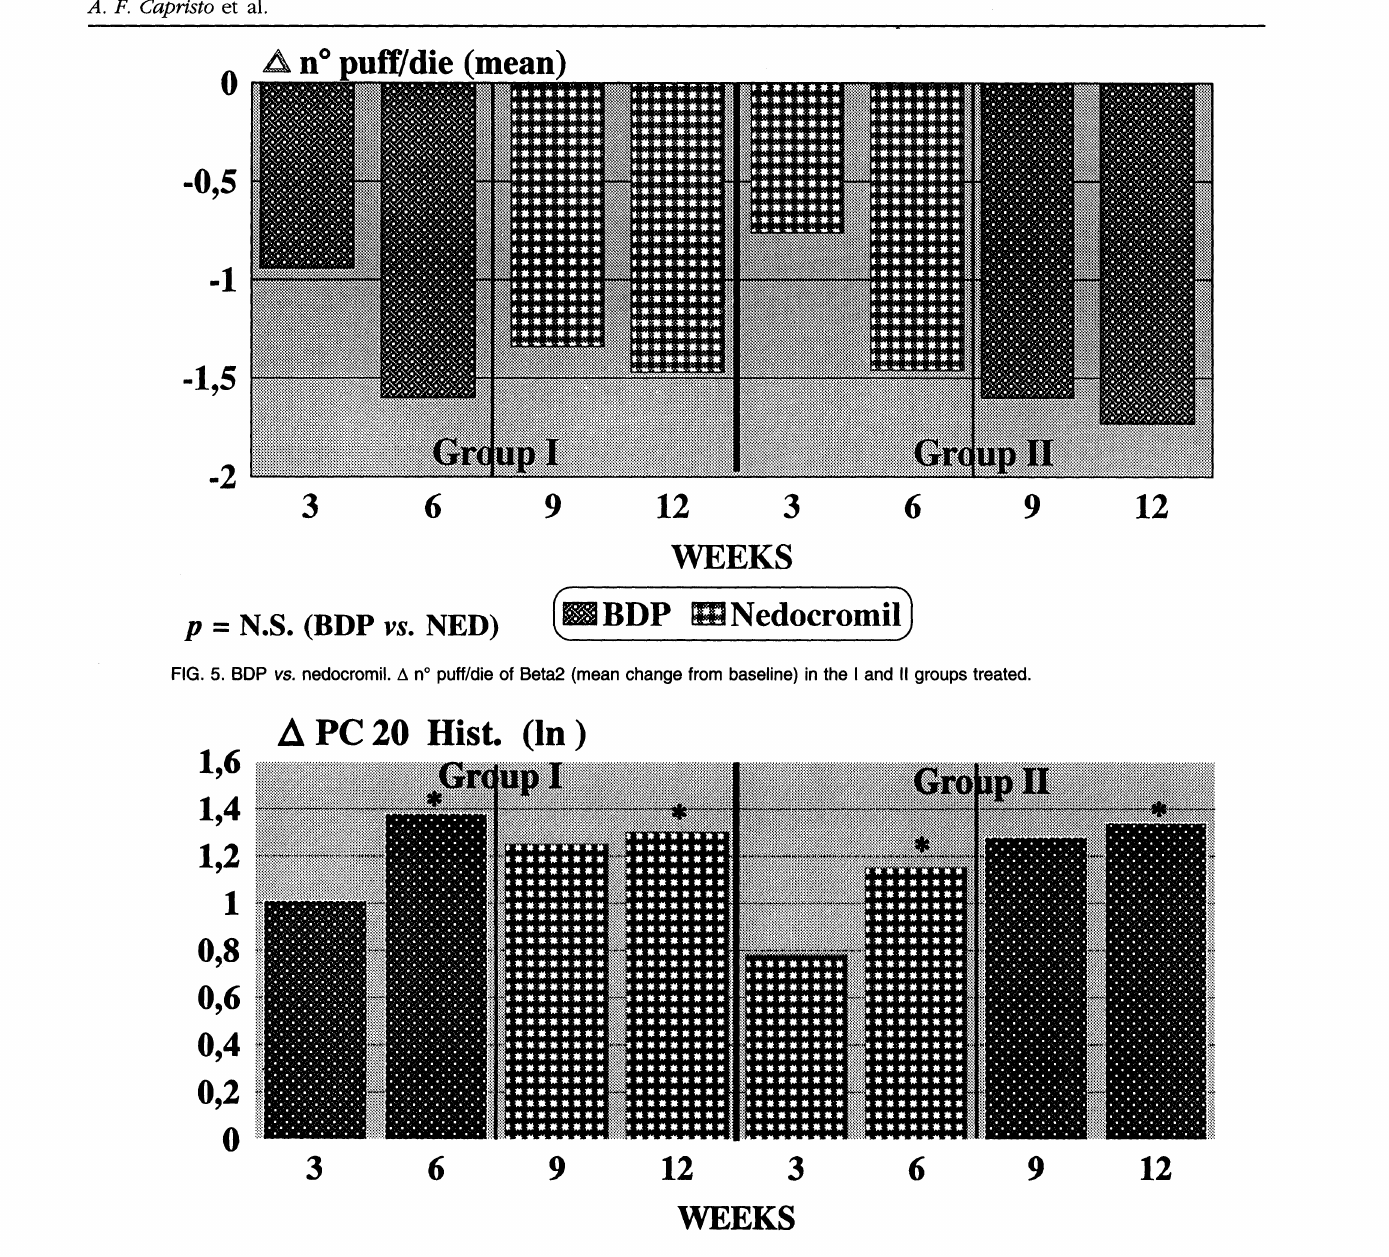
FIG. 6. BDP v& nedocromil. A PC 20 Histamine (mean change from baseline) in the and II groups treated.